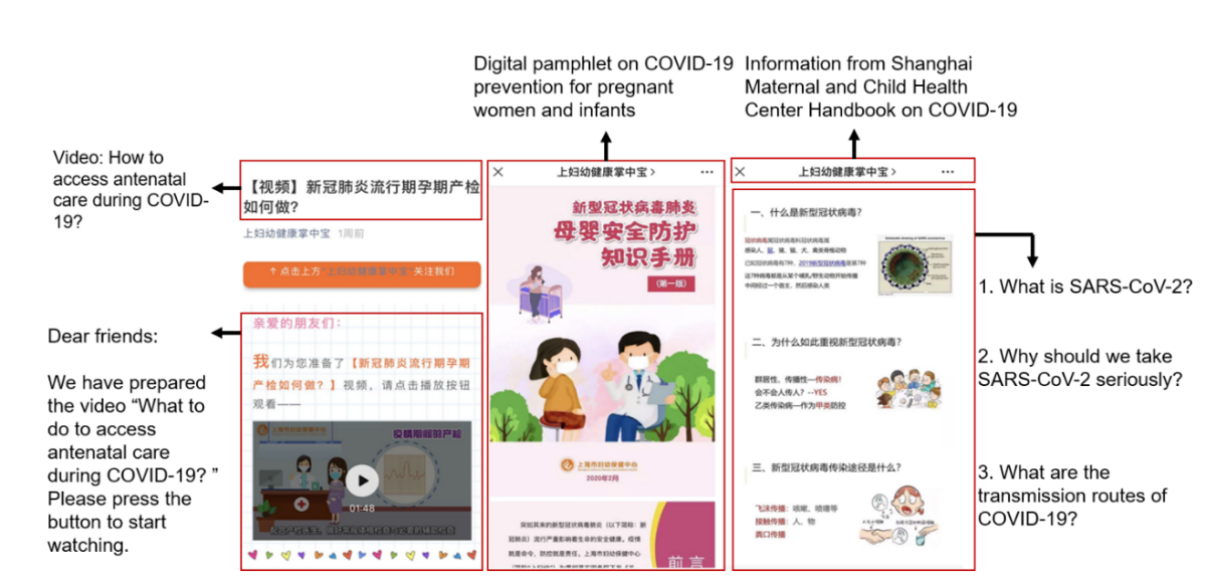
Figure 1. Examples of antenatal care information provided via a health institution’s official WeChat account. Screenshots of antenatal care information shared via the official WeChat account of Shanghai Maternal and Child Health Center, China, introducing when, where, and how should pregnant women receive antenatal care and COVID-19 prevention strategies for pregnant women and infants.